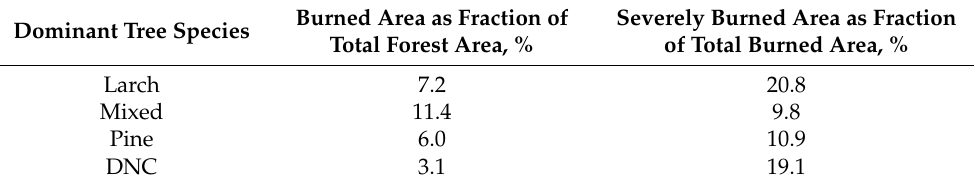
Table 1. Fire disturbance (2001–2021) for main forest